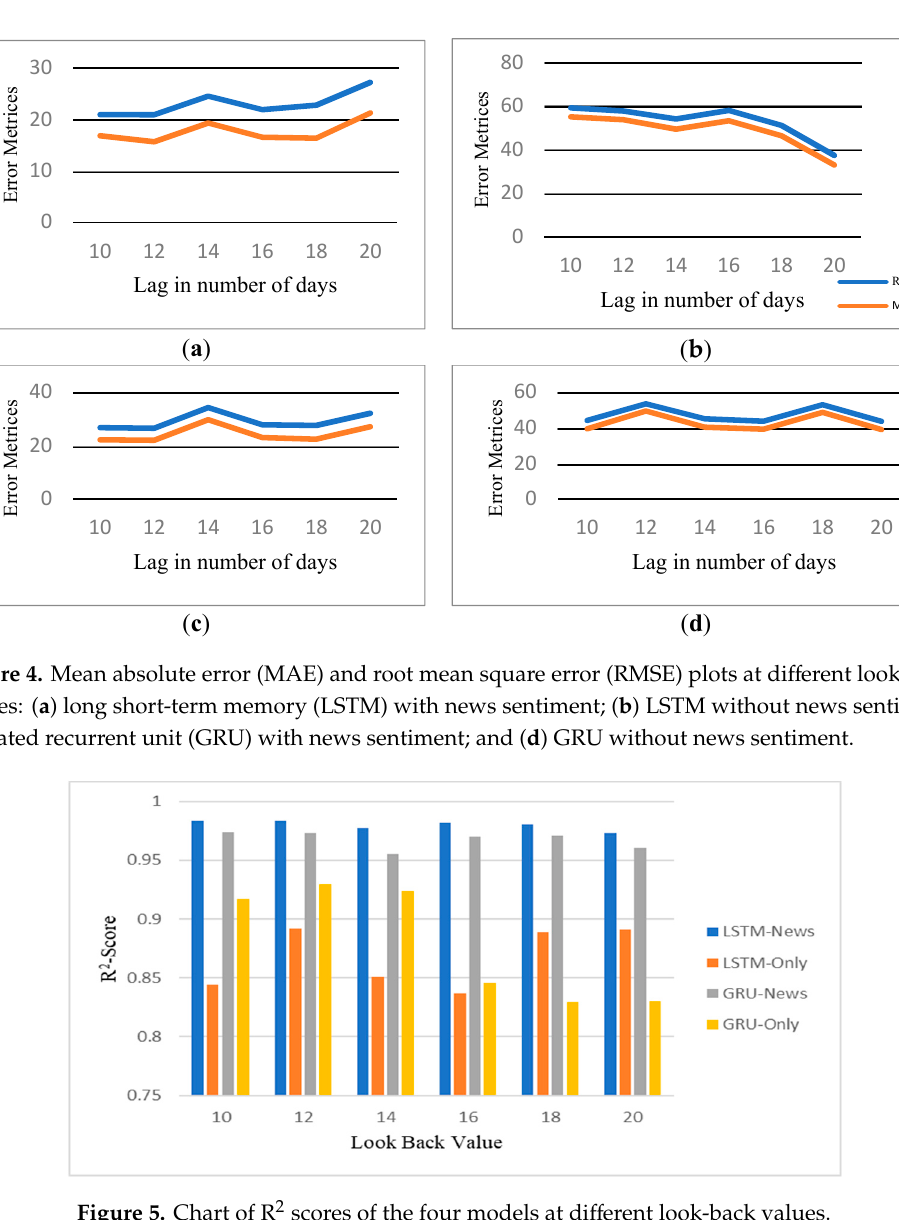
Figure 5. Chart of R 2 scores of the four models at different look-back values.